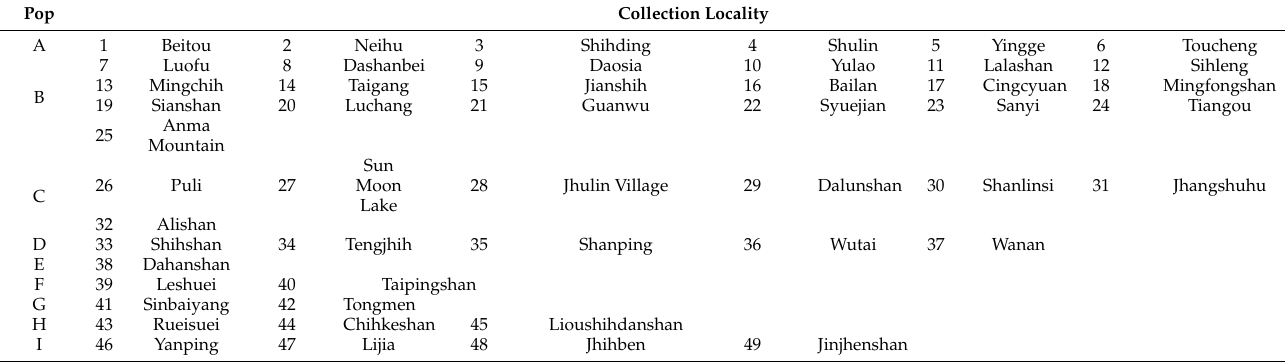
Table 1. Collection localities of the hilly lineage of Neolucanus swinhoei complex across Taiwan Island.